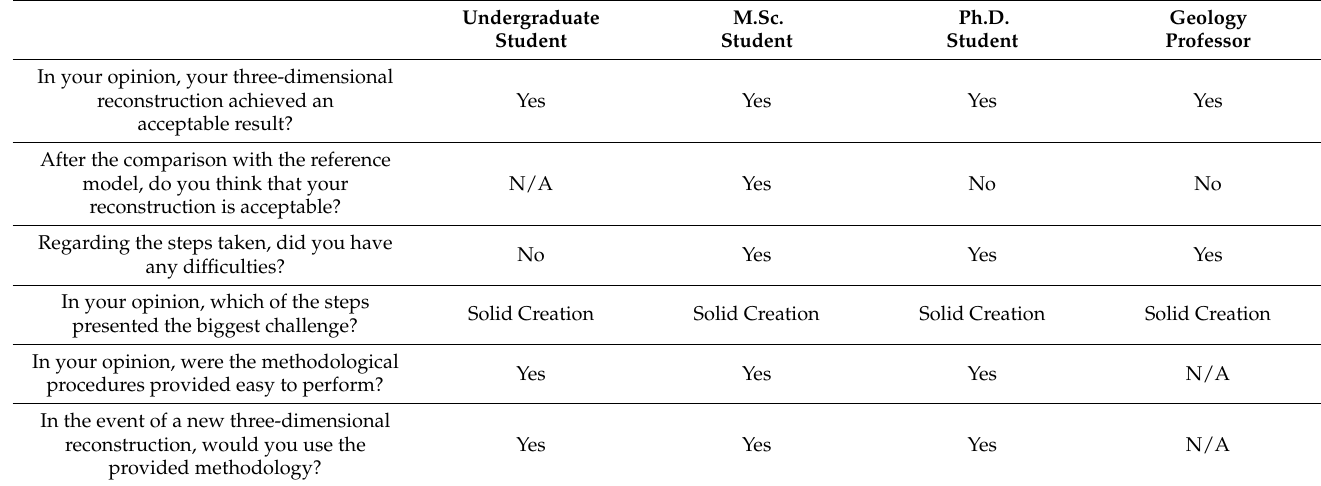
Table 6. Initial perception of the volunteers about 3D